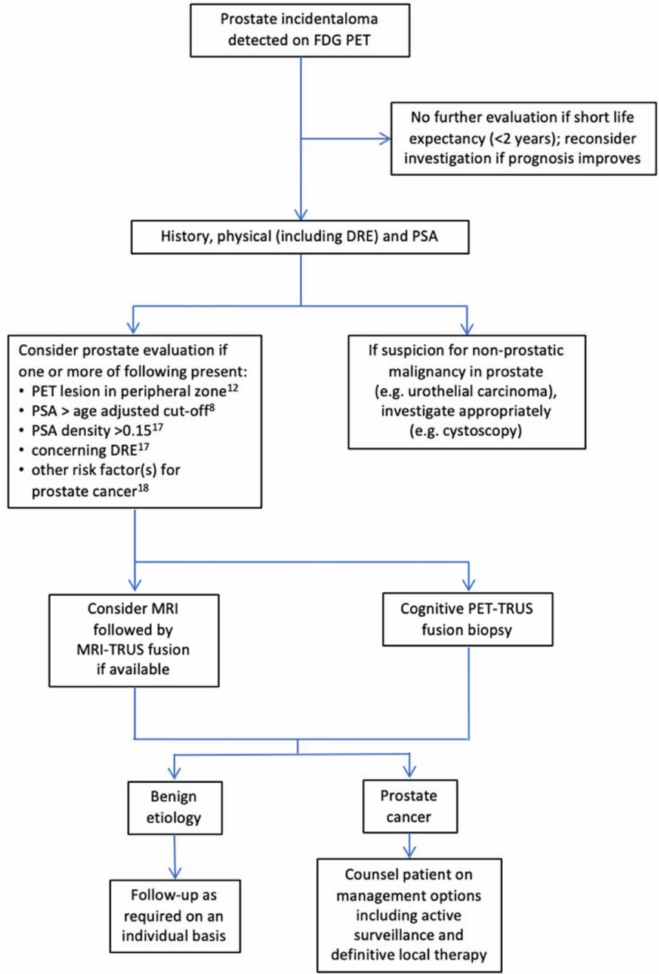
Figure 3. Tentative diagnostic algorithm to investigate prostate incidentalomas detected on FDG PET/CT. Adapted with permission from Mannas et al. [23]. DRE —digital rectal exam; MRI —magnetic resonance imaging; PSA —prostate-specific antigen; TRUS —transrectal